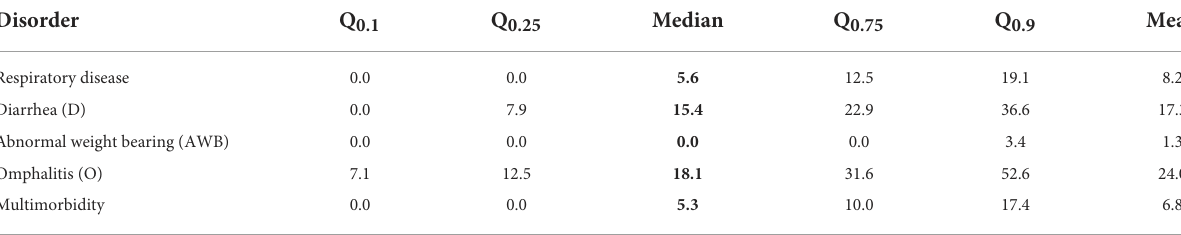
TABLE 8D Herd prevalence of disorders in pre-weaned dairy calves on 119 farms with 121–240 dairy cows * . Disorder